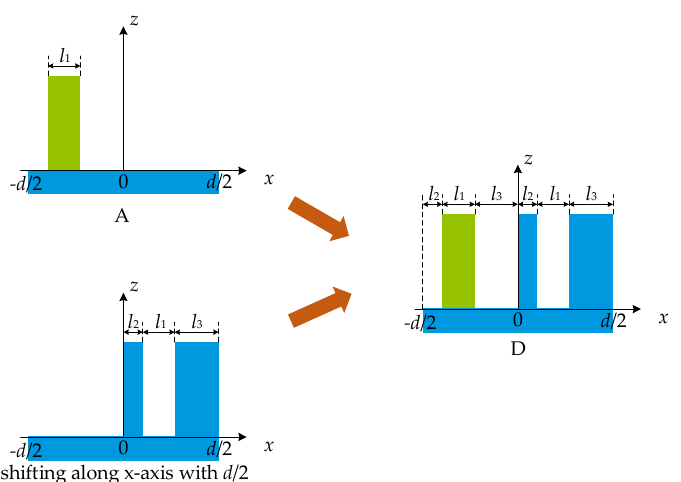
Figure 8. Grating D consists of grating A and grating B shifted along the x -axis with d/2. Substituting Equation (22) into Equation (23) yields: